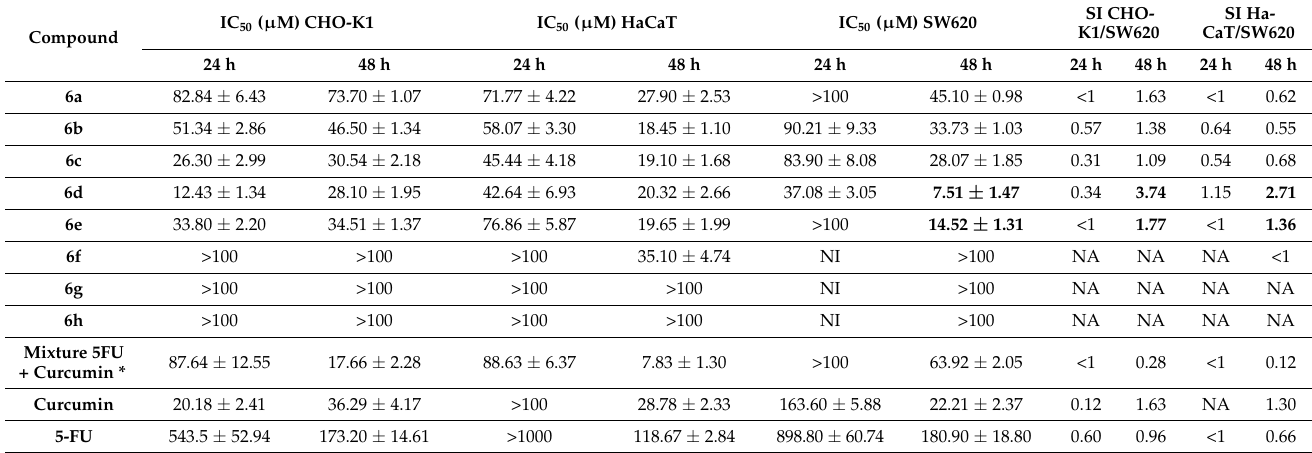
Table 2. Cytotoxic effect of 5-FU/Curcumin hybrids on SW620, HaCaT, and CHO-K1 cell